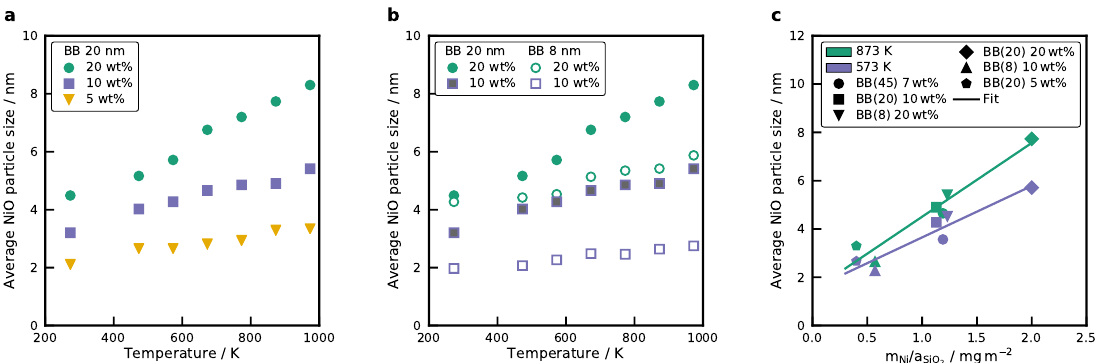
Figure 5. Average NiO nanoparticle size of the different samples calculated using the Scherrer equation Equation (1) for ( a ) BB(20) with different Ni loading, calcined at different temperatures and ( b ) comparison of BB(8) and BB(20) with two different Ni loadings at different calcination temperatures. ( c ) Average NiO crystal size in dependence of the m Ni / a SiO ratio for various catalysts with different 2 SiO 2 primary particle sizes (8, 20 and 45nm) and Ni loadings (5, 10 and 20wt%) at two temperatures (see Table S2). A linear regression is displayed to illustrate the observed